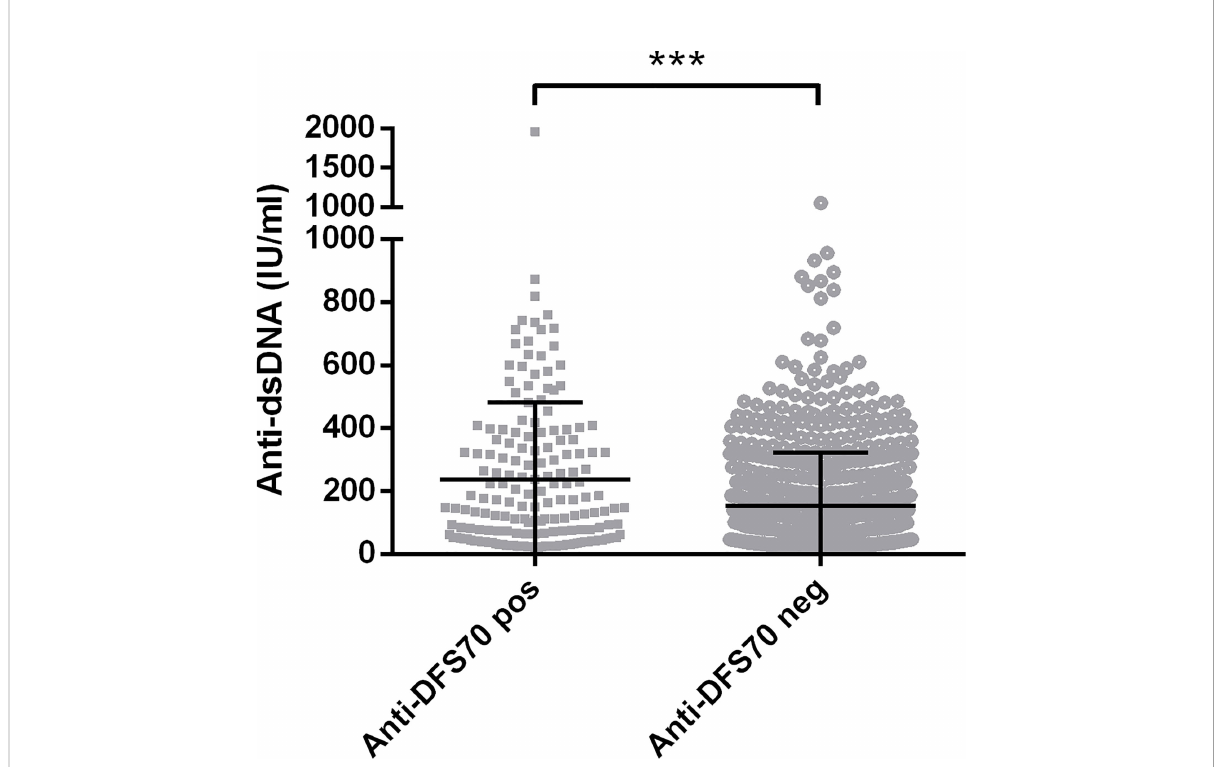
FIGURE 1 Comparison of levels of anti-dsDNA antibodies in 851 SLE patients with and without anti-DFS70 antibodies. Anti-DFS70 and anti-dsDNA antibodies were both measured by ELISA. DFS70, dense fi ne speckles 70; ELISA, enzyme-linked immunosorbent assay; neg, negative; pos, positive; SLE, systemic lupus erythematosus. *** p < 0.001.